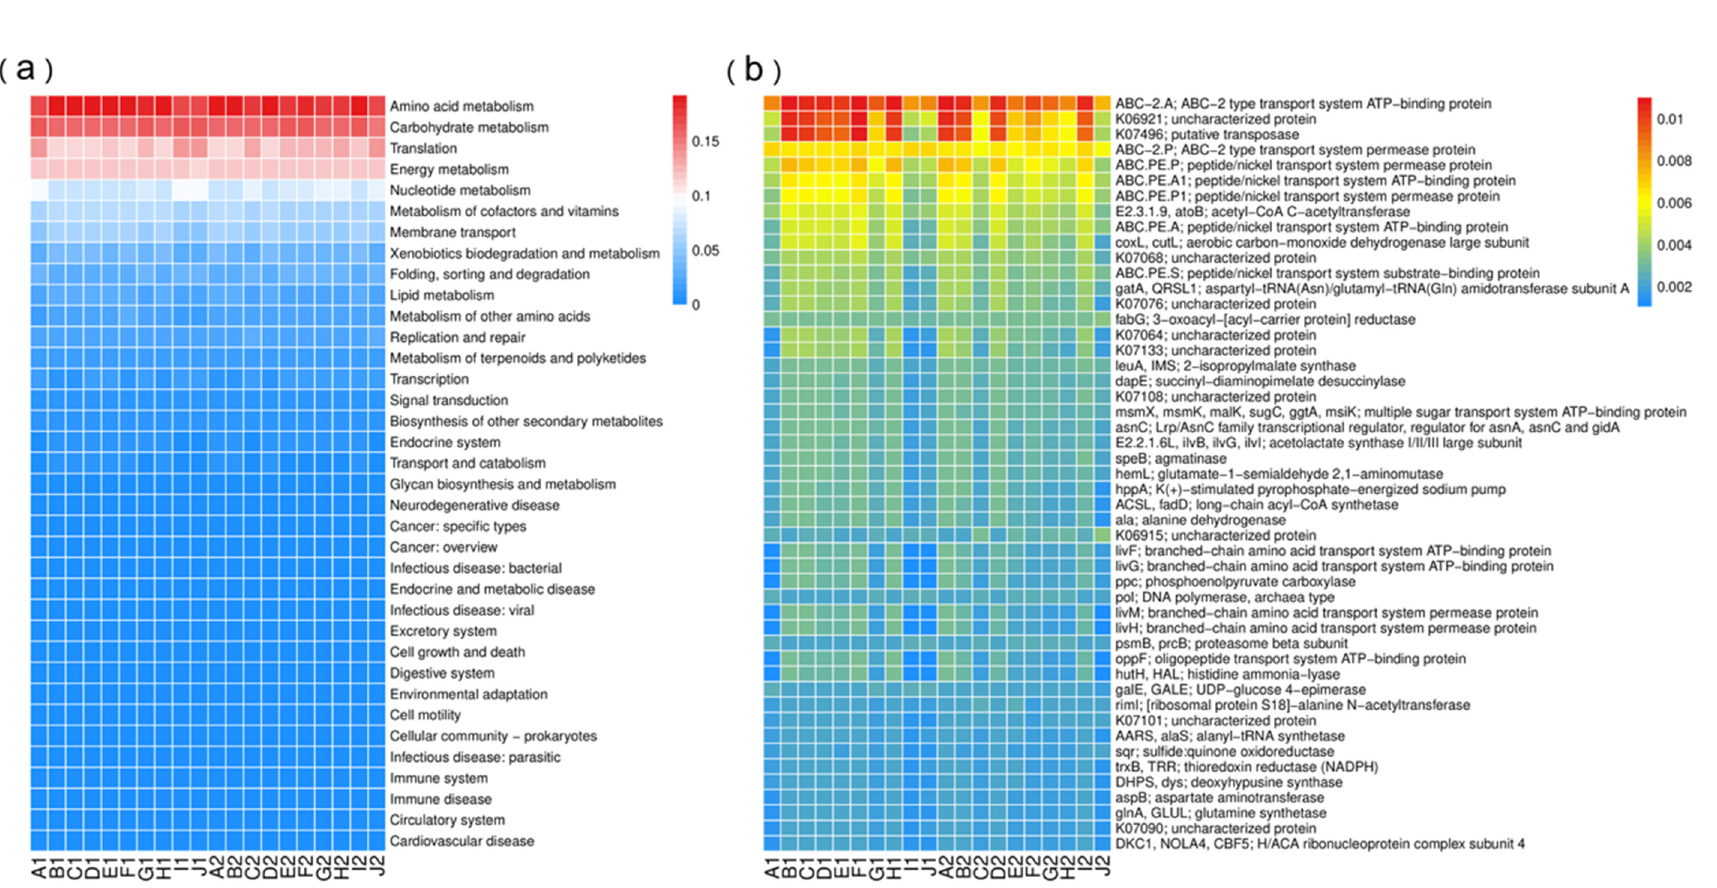
Figure 6. Heatmaps based on the relative abundance of the predicted metagenomes of KEGG genes ( a ) and metabolic pathways ( b ).